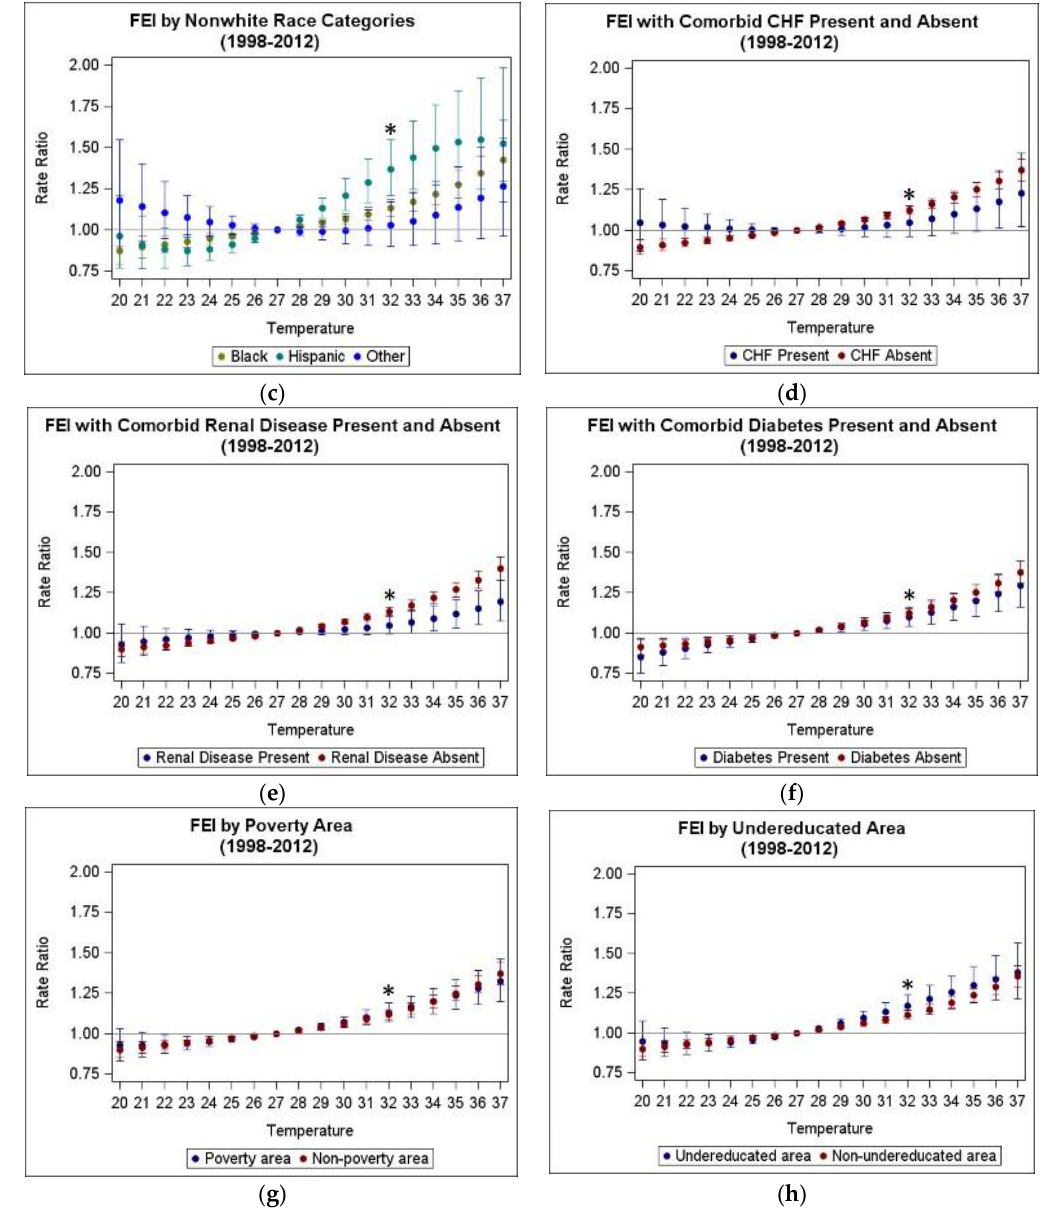
Figure 2. Plots of estimated rate ratios for fluid and electrolyte imbalance ED visits in relation to various temperature increments from the 25th percentile reference for TMax by modifiers of interest in Atlanta during warm seasons (May–September), 1998–2012: ( a ) FEI by Sex; ( b ) FEI by White and Nonwhite Race; ( c ) FEI by Nonwhite Race Categories; ( d ) FEI with Comorbid Congestive Heart Failure (CHF) Present and Absent; ( e ) FEI with Comorbid Renal Disease Present and Absent; ( f ) FEI with Comorbid Diabetes Present and Absent; ( g ) FEI by Poverty Area; ( h ) FEI by Undereducated Area. * RRs marked by asterisk are equivalent to those reported in Table 5 and represent the RR per IQR from the 25th to 75th